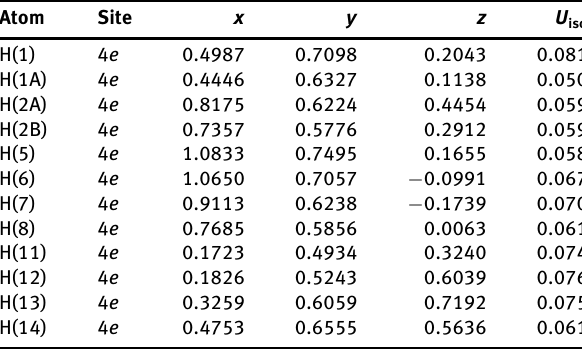
Table 2: Fractional atomic coordinates and isotropic or equivalent isotropic displacement parameters (Å 2